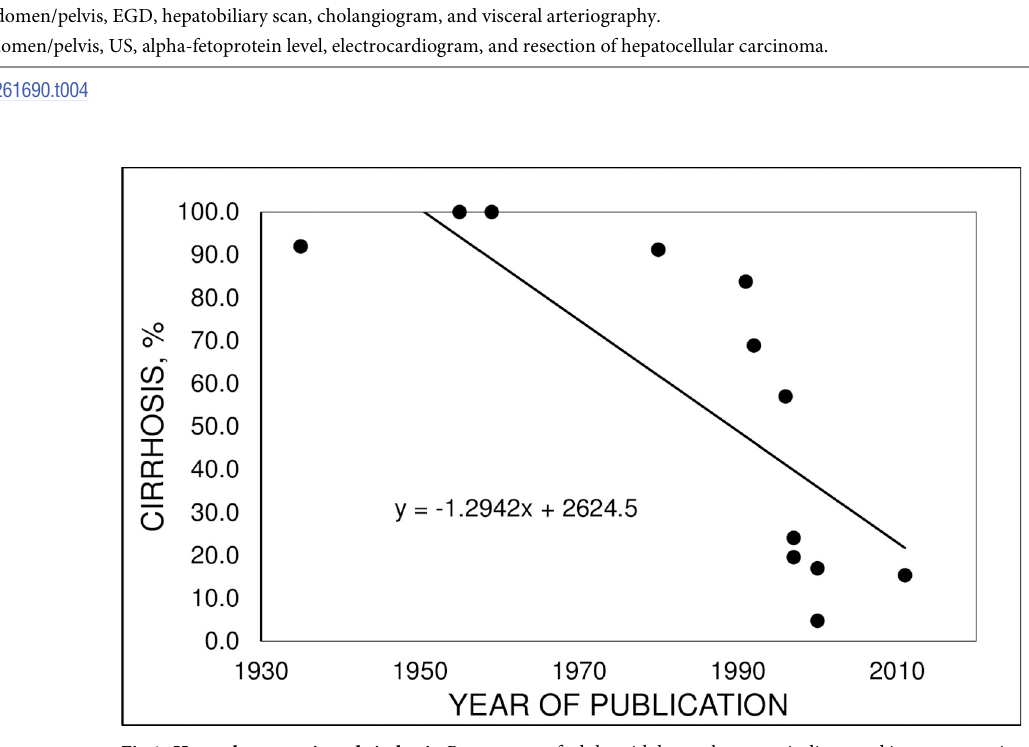
Fig 1. Hemochromatosis and cirrhosis. Percentages of adults with hemochromatosis diagnosed in non-screening venues who had cirrhosis in 12 reports [19,22,24–26,42–48].Greater proportions of men than women had cirrhosis